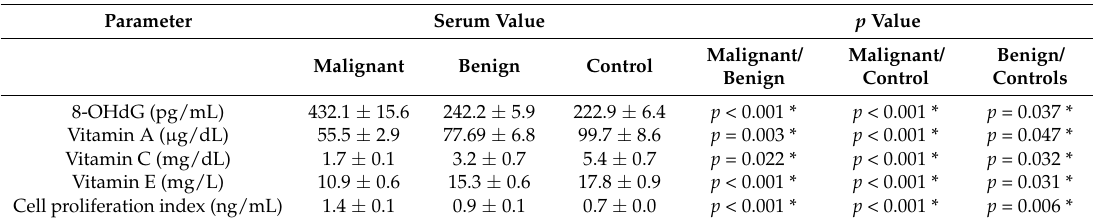
Table 3. Levels of non-enzymatic antioxidants, namely vitamin A, vitamin C, and vitamin E in patients with breast carcinoma, benign breast diseases, and controls.